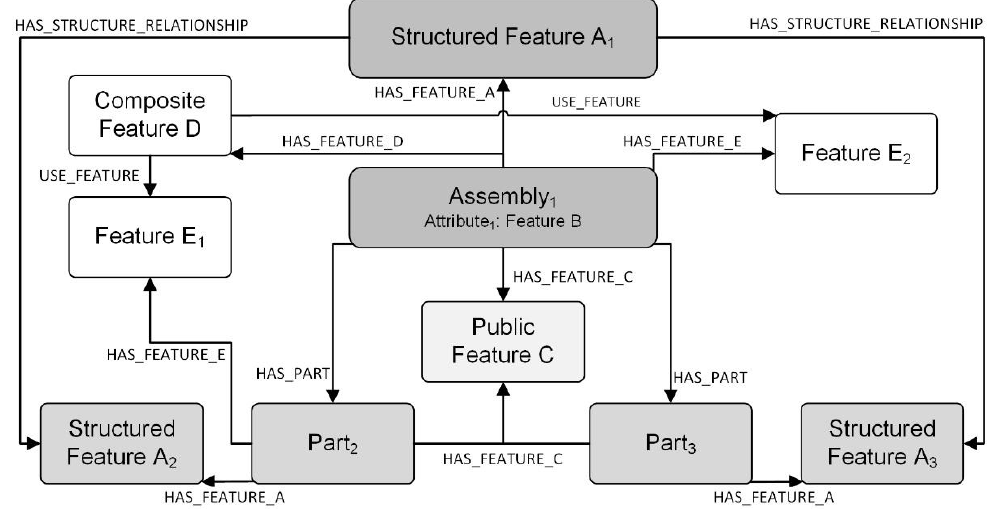
Figure 4. Diagram of the hierarchical feature ontology model of a mechanical product.